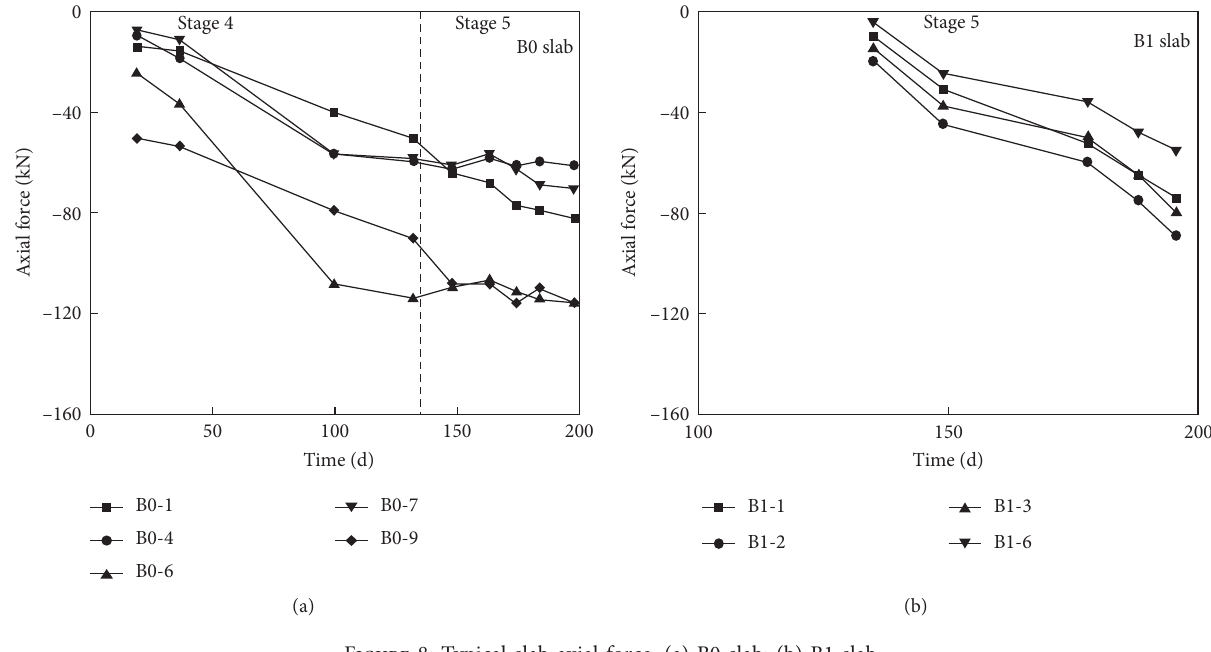
Figure 8: Typical slab axial force. (a) B0 slab; (b) B1 slab.